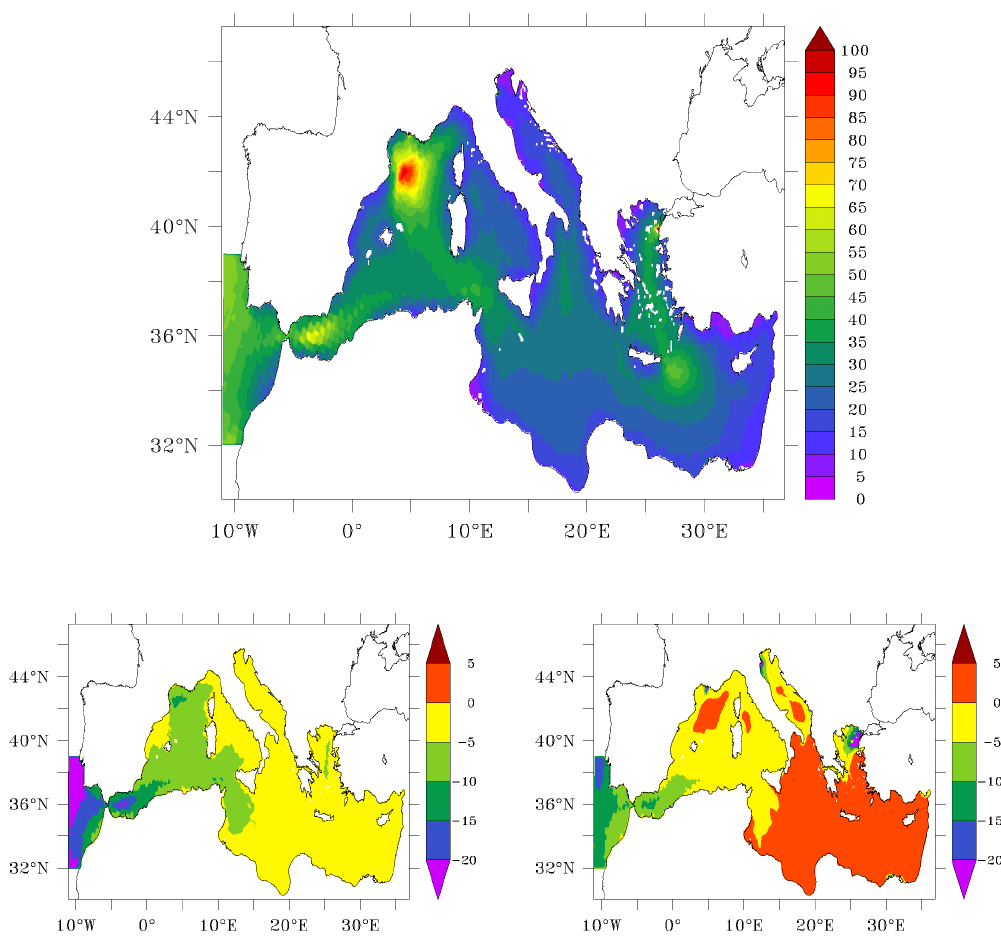
Figure 6. Cumulative air–sea flux of anthropogenic carbon (molm − 2 ) from 1800 to November 2001 shown as the total flux for the MED reference simulation (top) and for the other two simulations as differences: GLO − MED (bottom left) and VAR − MED (bottom right).